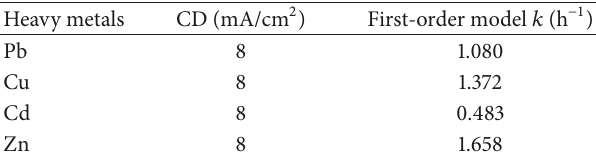
Table 1: Predicted parameters for the pseudo-first-order removal rate of the metal mixture in the electrocoagulation system